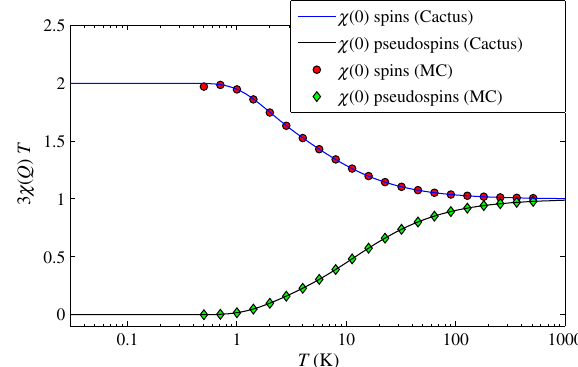
FIG. 3. Analytical and numerical calculations of the spin and pseudospin susceptibilities showing the temperature dependence T for pseudospins, from of 3 (cid:4)T for spins, from Eq. (1), and 3 (cid:4) 0 ¼ 1 : 8 K . The susceptibility of the Eq. (3). All data are for J eff NNSI model obtained by MC simulation is also compared with the analytical theory.